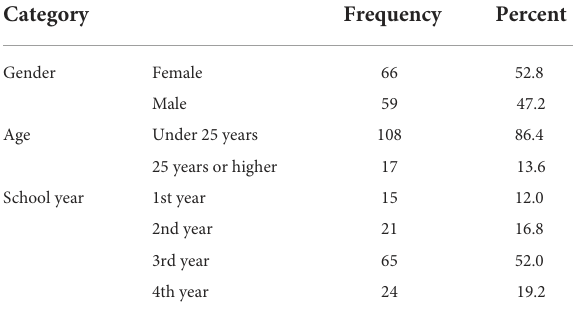
TABLE 1 Sociodemographic characteristics ( N = 125